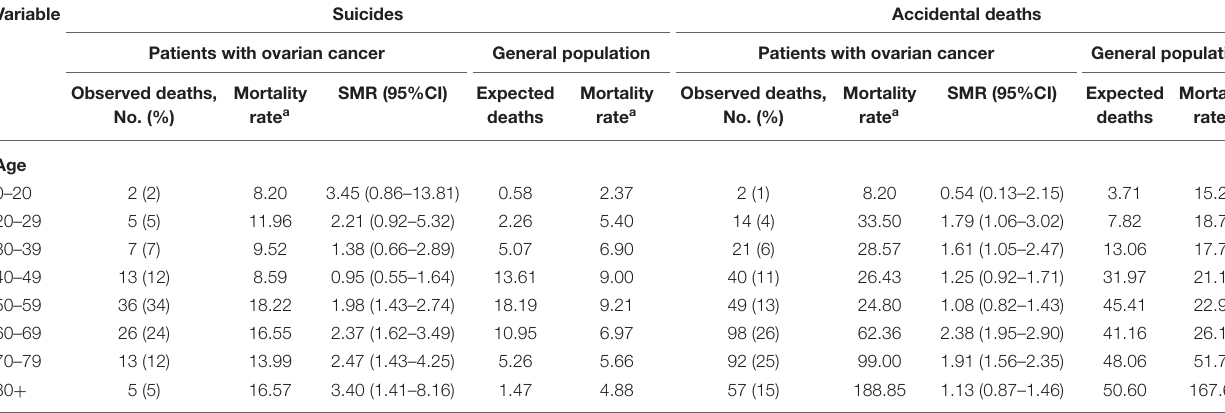
TABLE 2 | The risk of suicide and accidental death among patients with ovarian cancer by age at diagnosis. Variable Suicides Accidental deaths Patients with ovarian cancer General population Patients with ovarian cancer General population Observed deaths, Mortality SMR (95%CI) Expected Mortality Observed deaths, Mortality SMR (95%CI) Expected Mortality ratea No. (%) rate a deaths rate a No. (%) rate a deaths